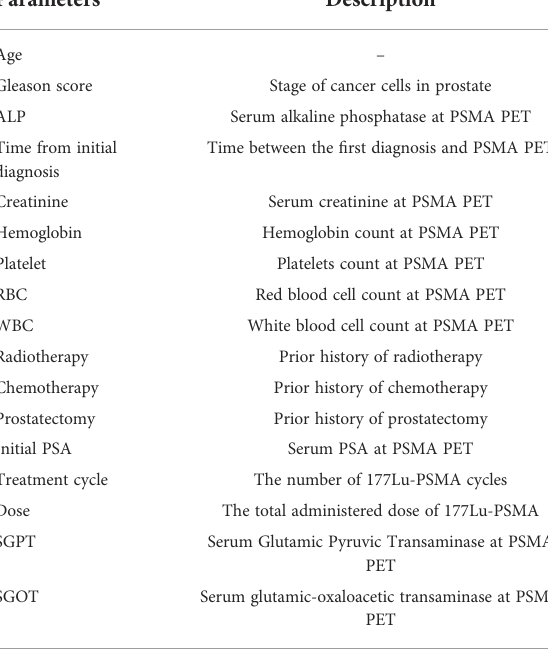
TABLE 2 Description of the clinical